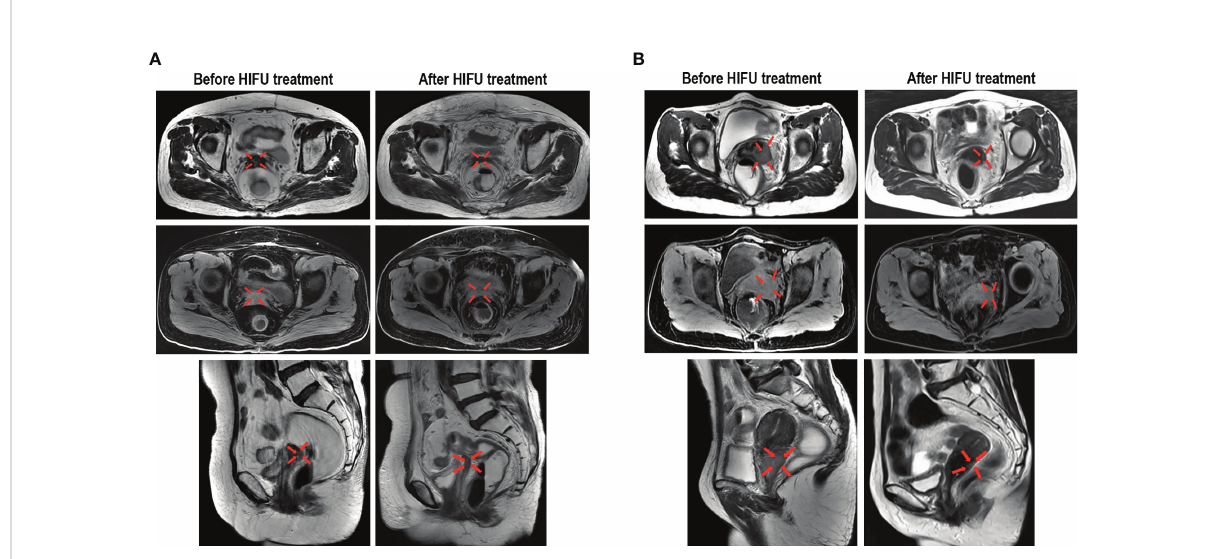
FIGURE 2 Representative images demonstrating the reduction of cervical cancer lesions following HIFU treatment. (A) Images from a 54-year-old patient with stage IIB cervical cancer before and after HIFU treatment, which display residual lesions that were previously treated with CRT. (B) Images from a 55-year-old patient with stage IIIB cervical cancer before and after HIFU treatment, which display recurrent lesions that occurred within an area that was previously irradiated. The transverse T2 MR images, transverse T1-fs MR images and sagittal T2 MR images all show that the tumor was signi fi cantly